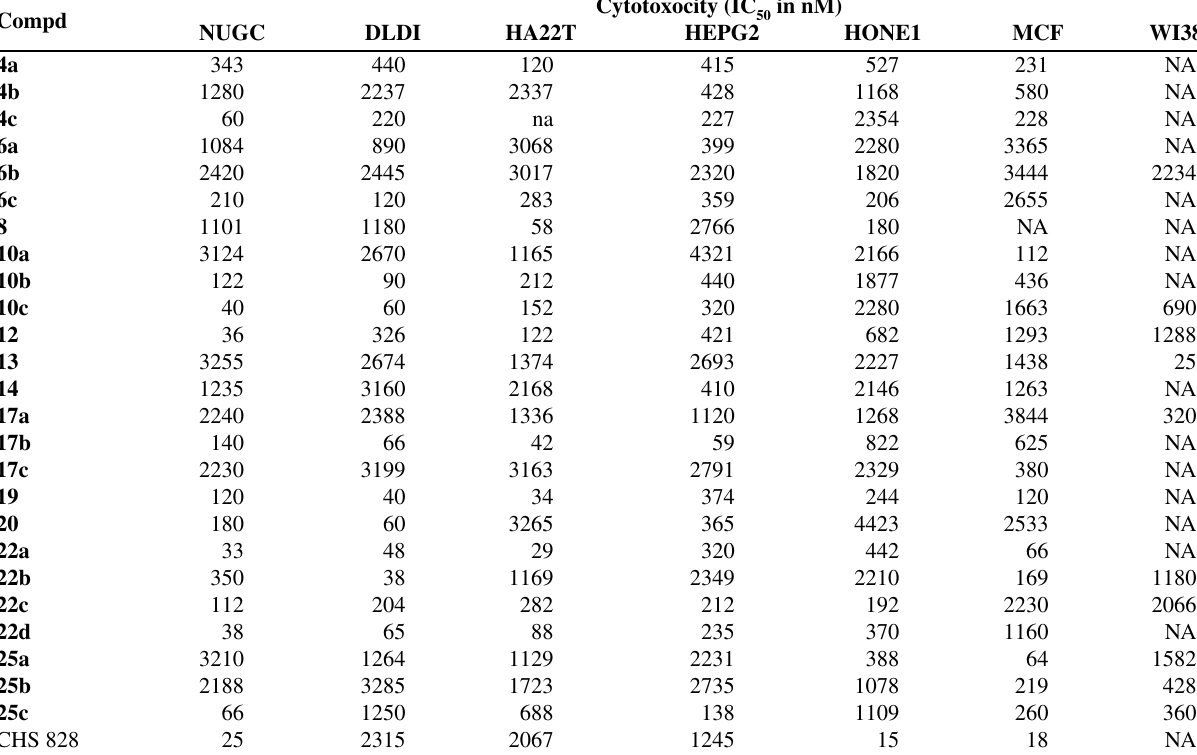
Cytotoxocity (IC in 50